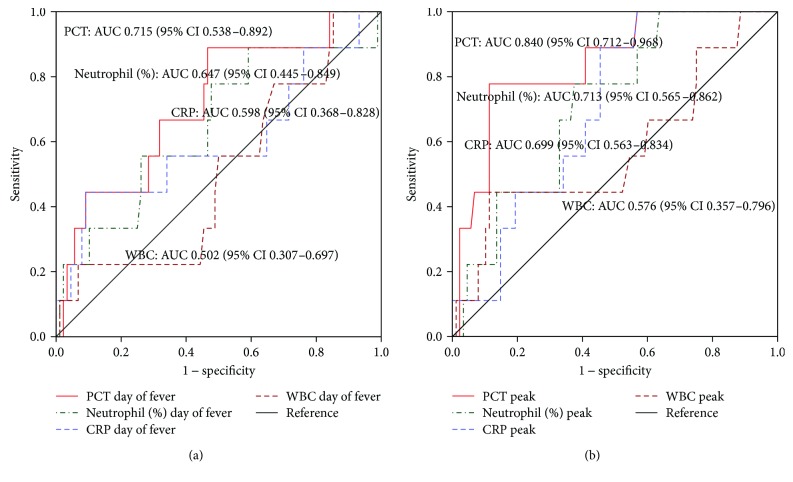
Receiver operating characteristic (ROC) curves and area under the curve (AUC) determined to predict the bacterial infection in patients with fever after TACE and/or RFA based on day of fever (a) and peak (within 7days of fever) (b) level of PCT (procalcitonin), CRP (C-reactive protein), WBC (white blood cells) counts, and neutrophil percentage.